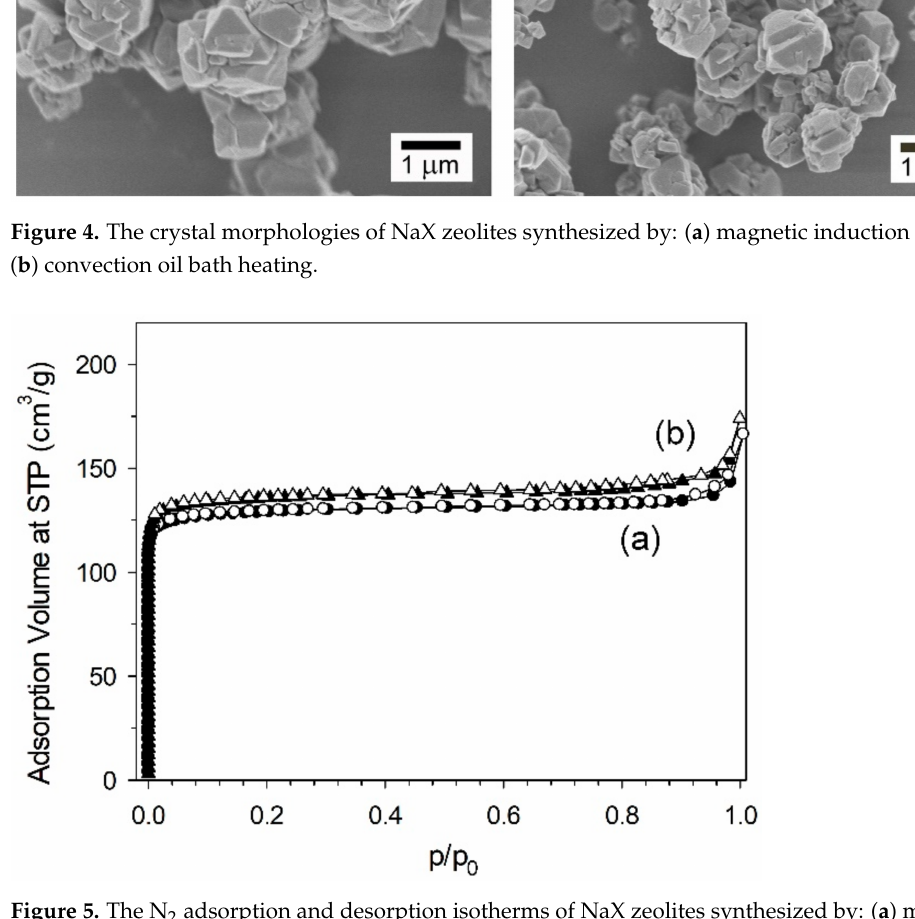
Figure 5. The N 2 adsorption and desorption isotherms of NaX zeolites synthesized by: ( a ) magnetic induction heating; ( b ) convection oil bath heating. (Closed symbol: adsorption; open symbol: